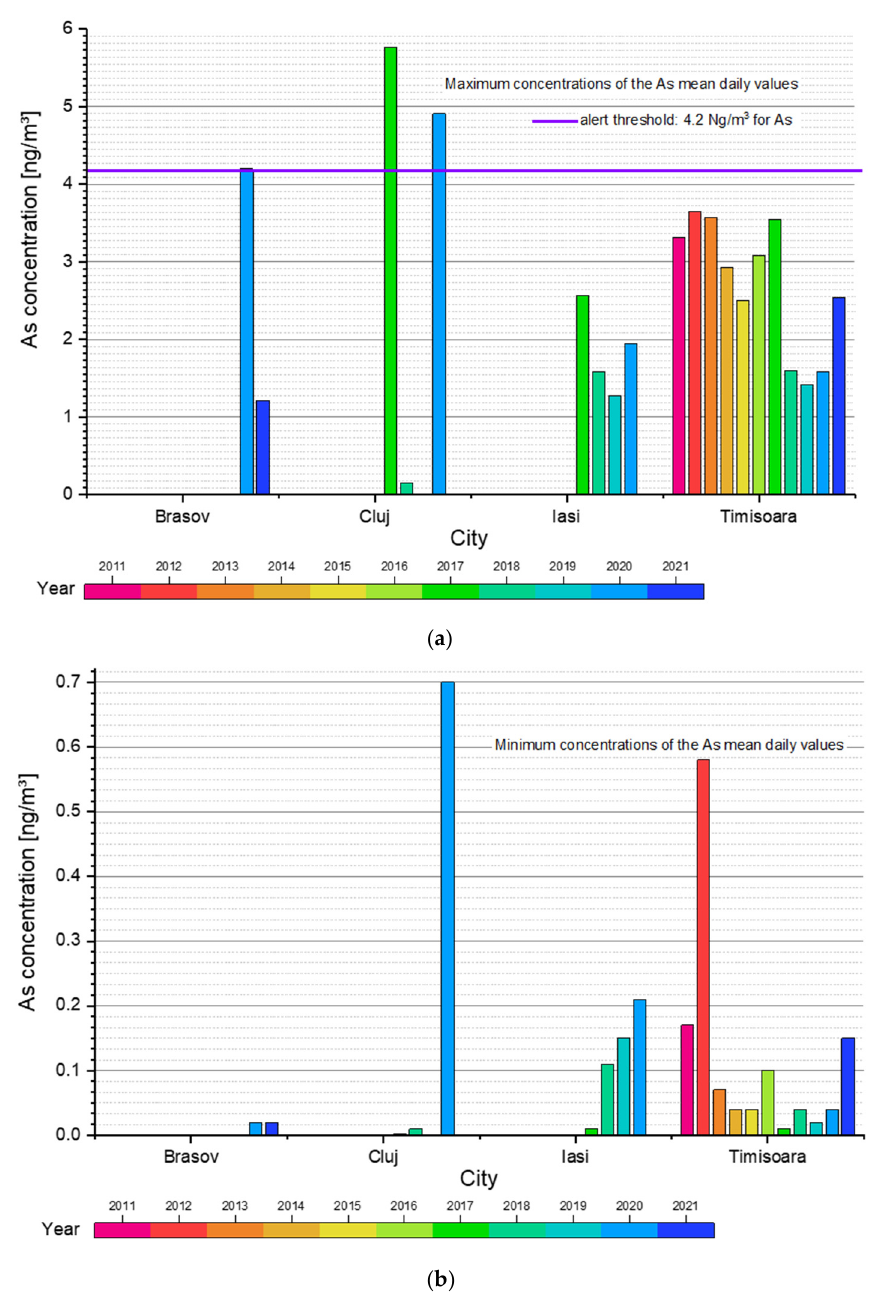
Figure 7. ( a ) Maximum concentrations of As mean daily values depending on the alert threshold; ( b ) minimum concentrations of As mean daily values depending on the alert threshold.